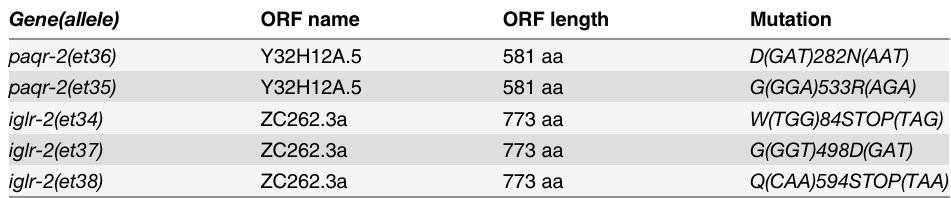
Table 1. Description of the novel paqr-2 and iglr-2